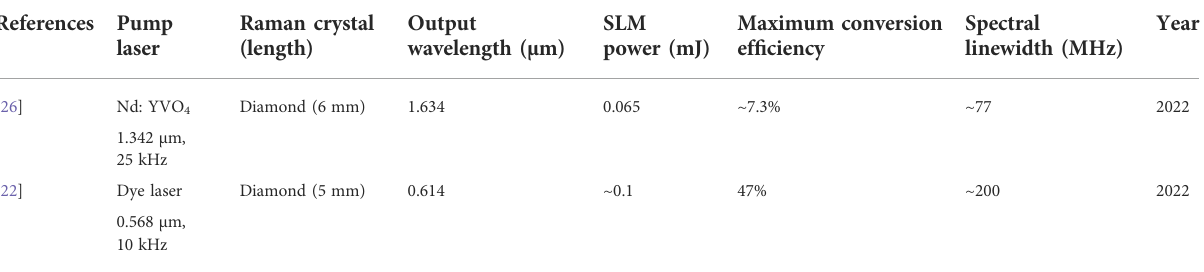
TABLE 4 The review of SLM ns-pulsed